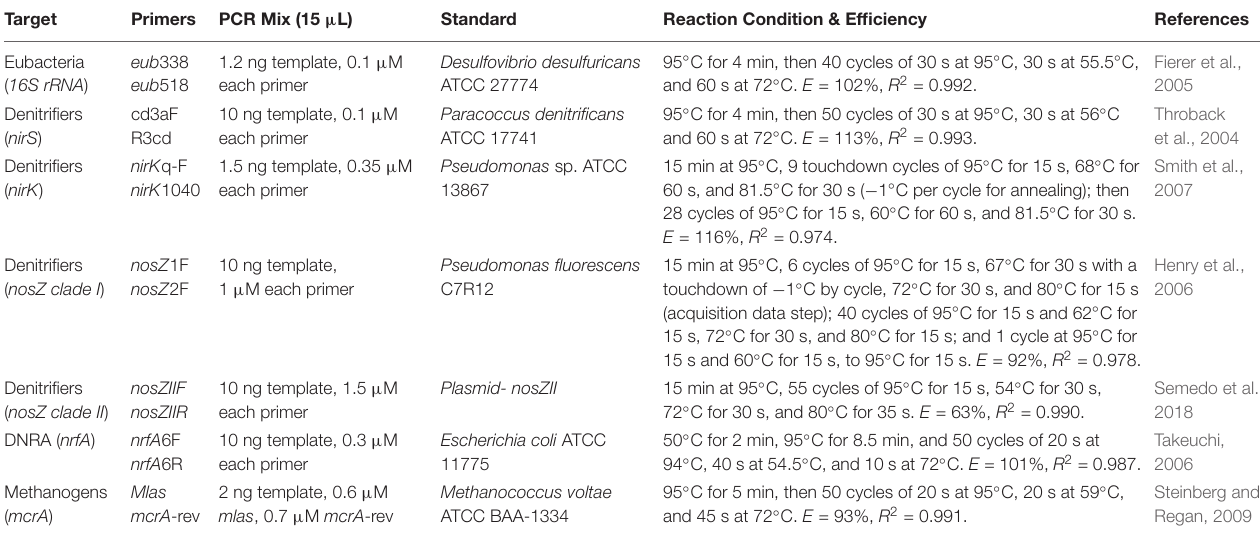
TABLE 2 | Primers and reaction conditions for qPCR